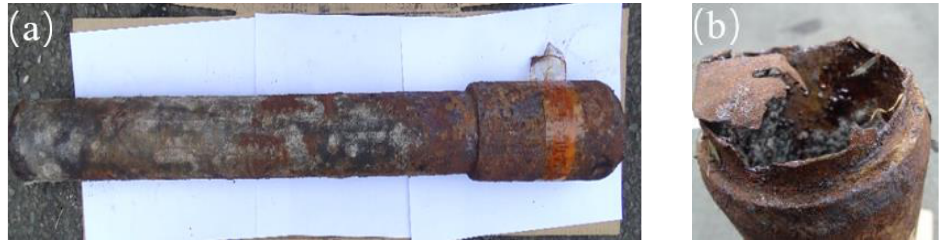
Figure 14. Fracture of tubing due to corrosion. ( a ): Tubing body; ( b ): local fracture.